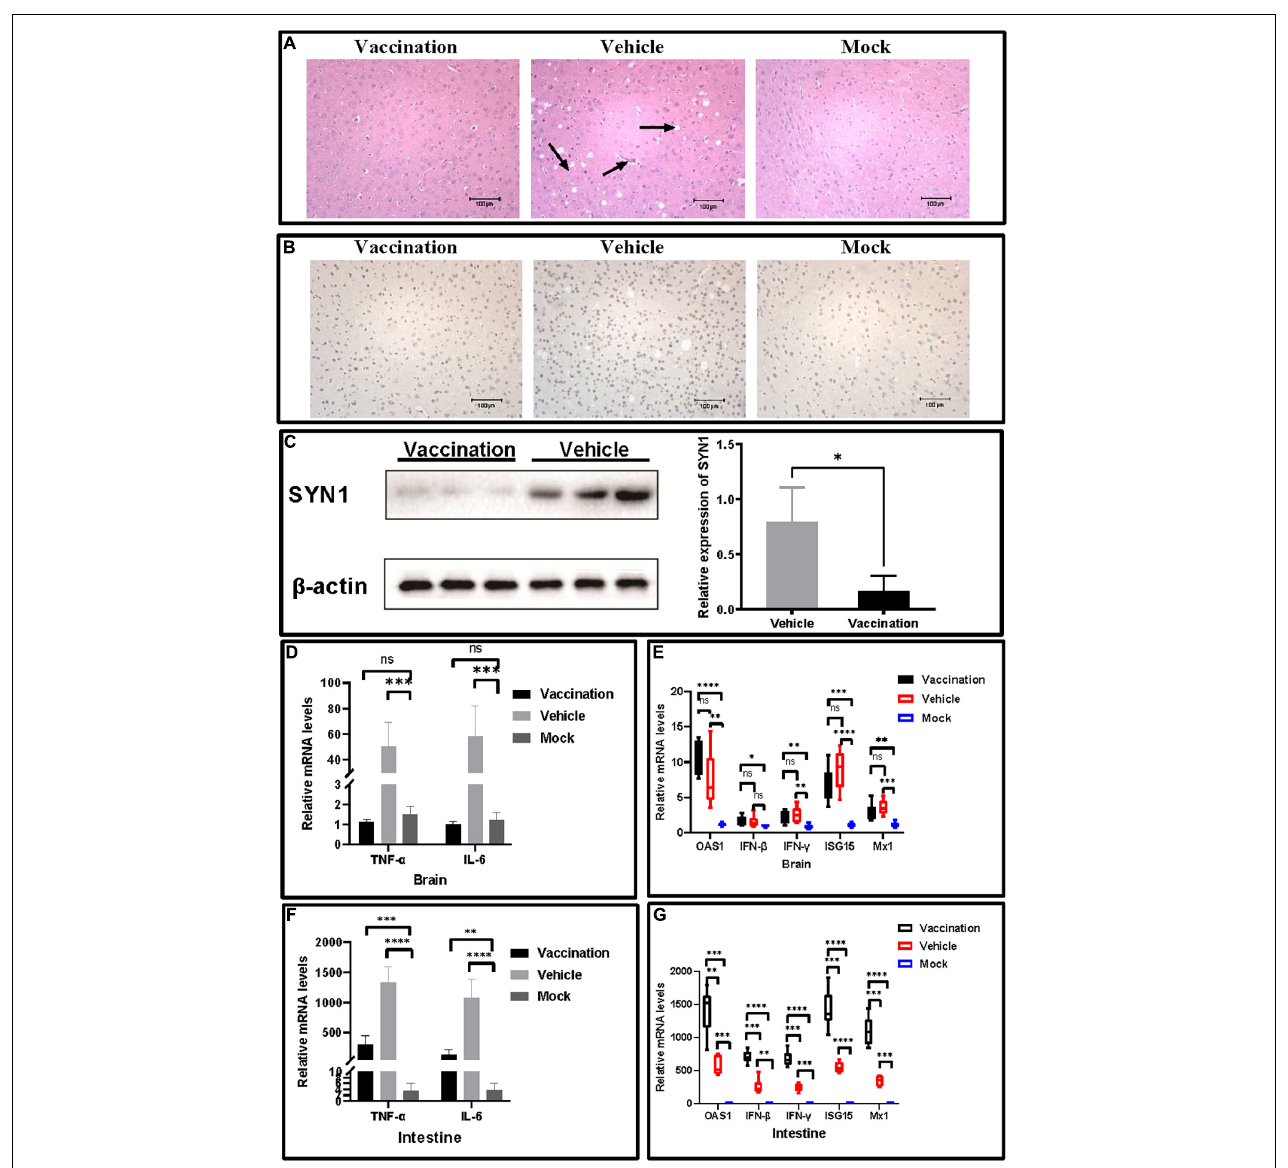
FIGURE 4 | The protective effects of pseudorabies virus XJ delgE/gI/TK in mice brain. (A) Histopathological observations of mice brain injected with the indicated viral strain or Dulbecco’s modified Eagle’s medium. The arrows from the left to the right show nuclear cleavage, neuron phagocytosis, and vacuolar neuronal degeneration in the brain, respectively (hematoxylin and eosin staining, × 200 magnification). (B) Immunohistochemistry detection of SYN1 in mice. Comparison of the SYN1 expression in mice brain using immunohistochemistry. (C) Western blot analysis and relative quantification of the band density of SYN1. (D) The fold change of TNF- α and IL-6 in the brain was determined by qRT-PCR. (E) The fold change of TNF- α and IL-6 in the intestine was determined by qRT-PCR. (F) The fold change of IFN- β , IFN- γ , ISG15, Mx1, and OAS1 in the brain was determined by qRT-PCR. (G) The fold change of IFN- β , IFN- γ , ISG15, Mx1, and OAS1 in the intestine was determined by qRT-PCR. Data are presented as mean ± SD ( n = 6). ∗ P < 0.05, ∗∗ P < 0.01, *** P < 0.001, **** P <